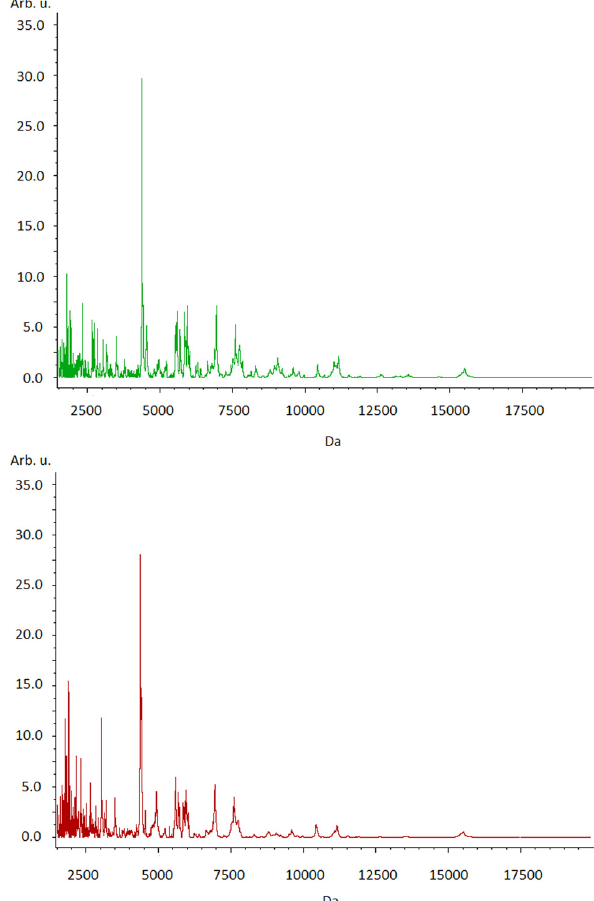
Figure 1: The average mass spectra of the salivary samples from TMD patients ( green line graph ) and healthy control ( red line graph ) . x - axis, mass - to - charge ratio ( m / z ) ; y - axis, relative